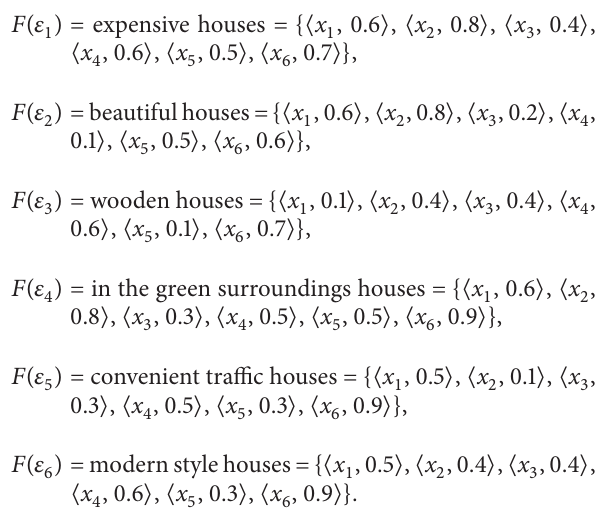
Table 2 is the tabular representation of the fuzzy soft set (𝐹, 𝐴)